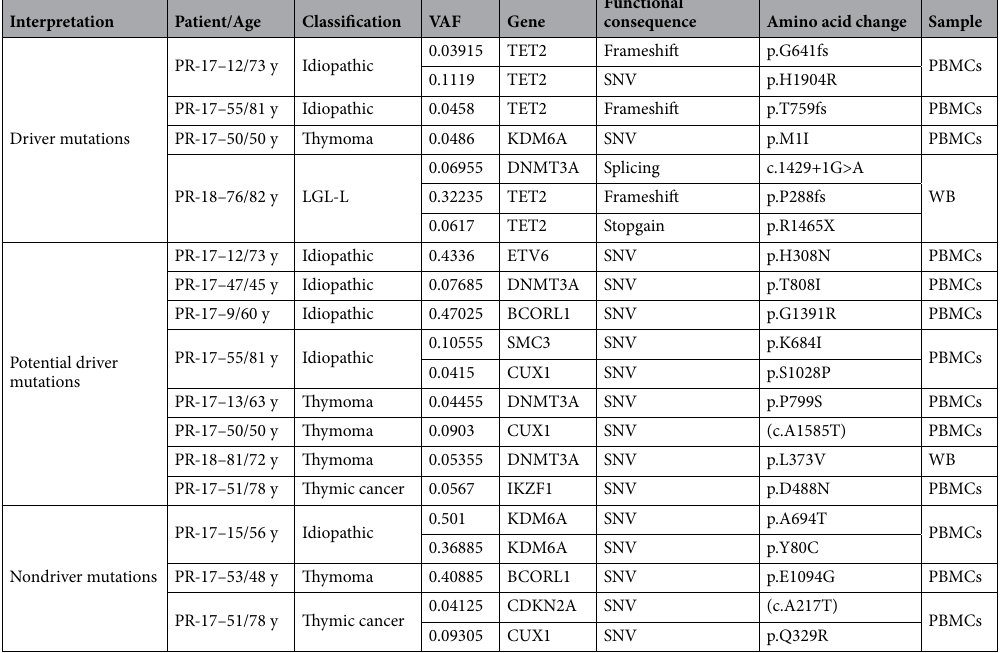
Table 1. Driver and nondriver mutations in pure red cell aplasia. LGL-L, large granular lymphocyte leukemia; PBMCs, peripheral blood mononuclear cells; WB, whole blood.